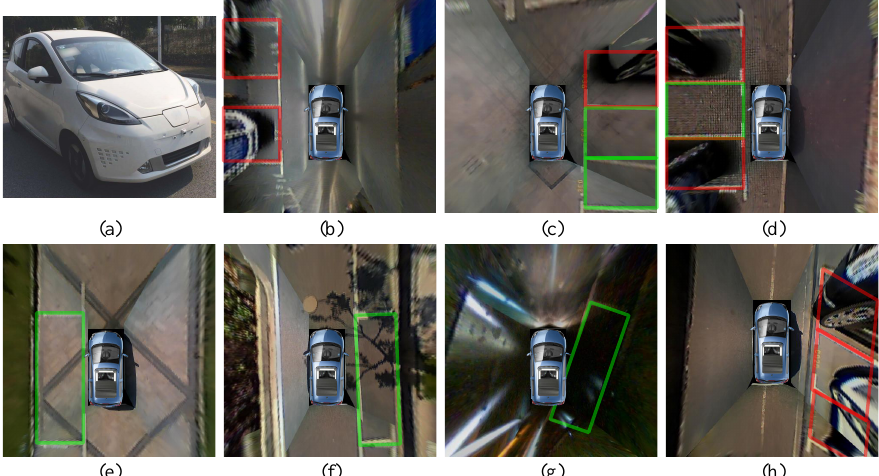
Figure 1. Typical scenes for vision-based parking area detection using green and red to represent vacancy or not. ( a ) Testing vehicle ( b ) Vertical parking areas in underground garage ( c ) Vertical parking areas on marble ground ( d ) Vertical parking areas with brick texture and similar line and ground color ( e ) Parallel parking areas on parquet ground ( f ) Parallel parking areas with strong shadow ( g ) Parallel parking areas at night ( h ) Oblique parking